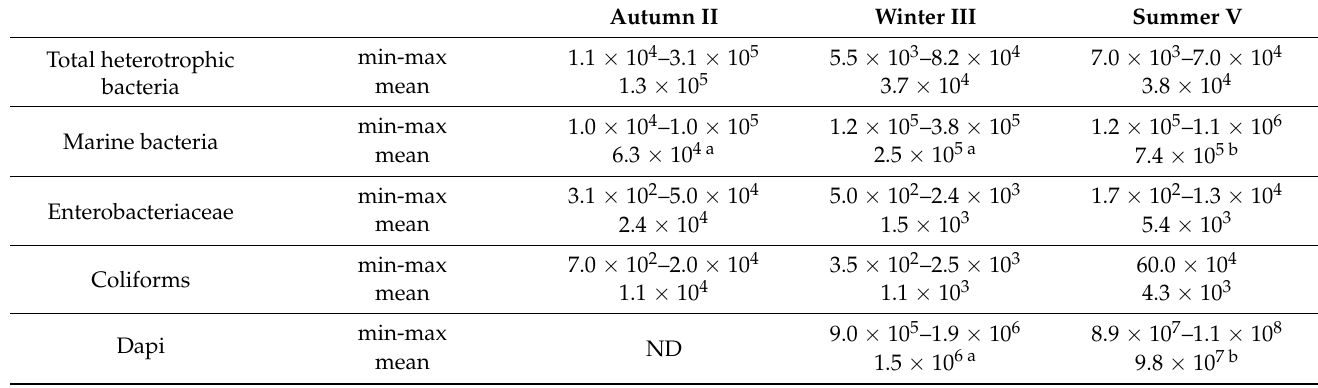
Table 1. Intestinal cultivable and not cultivable bacteria (DAPI counts) of mullets along the different seasons (cfu g − 1 ). ND: not detected.